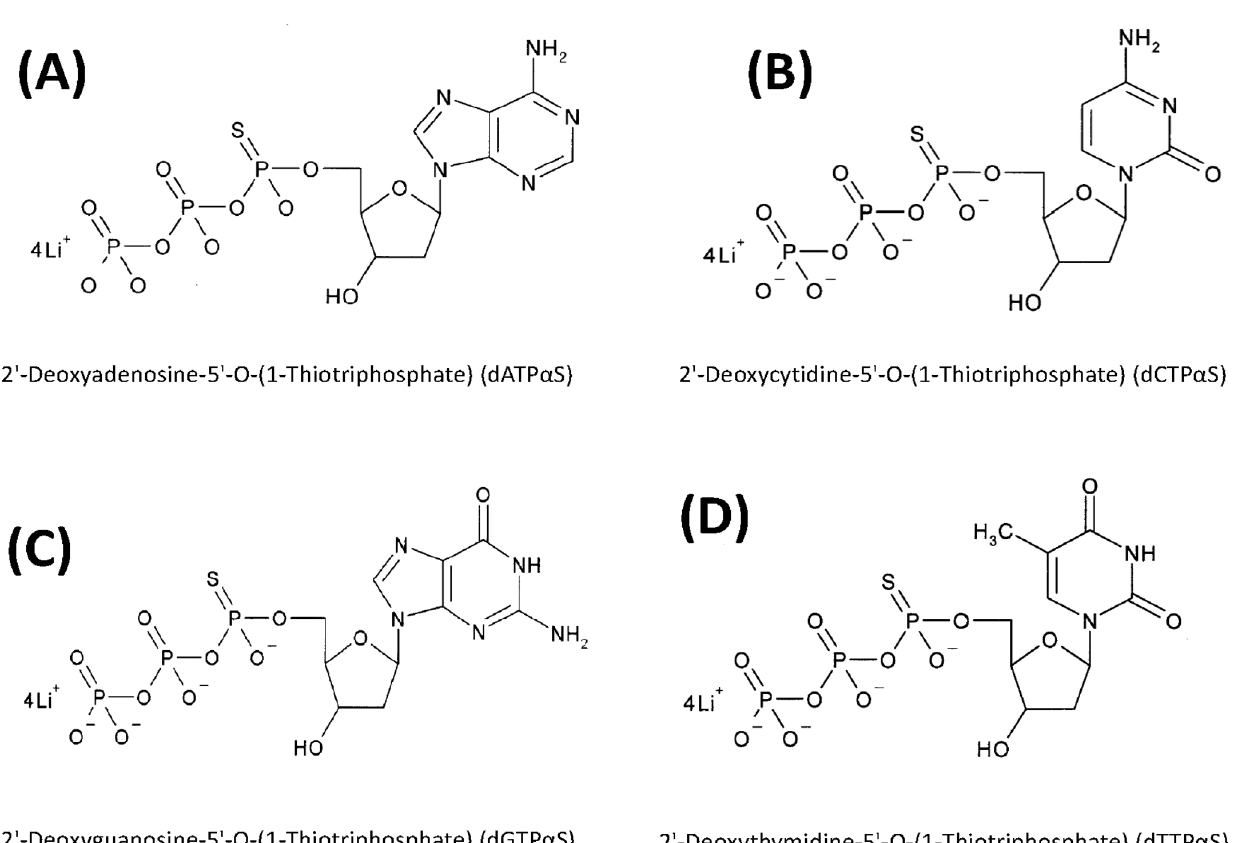
Figure 1. Molecular structure representation of dNTP a Ss.